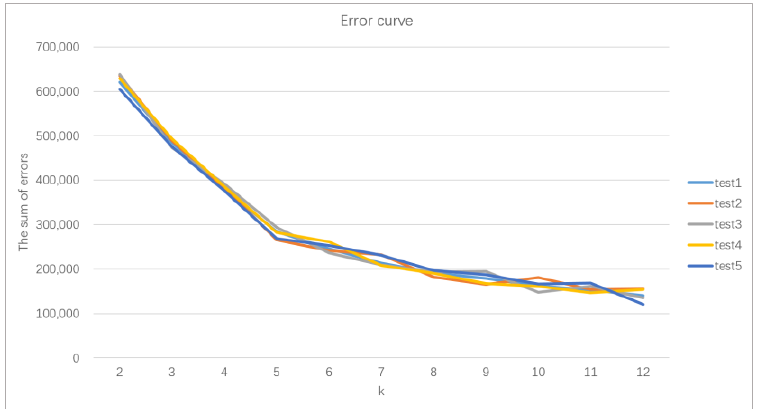
Figure 8. Equipment of data source.